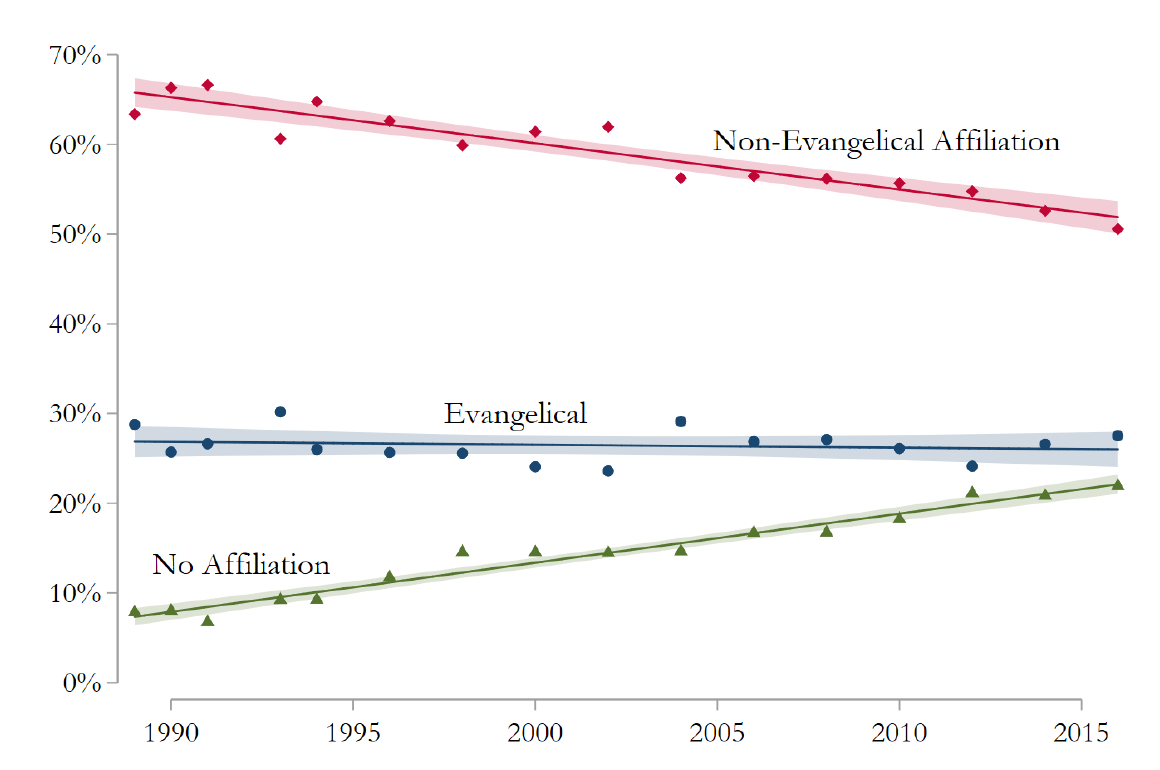
Figure 5: Type of affiliation over time, General Social Survey. Source: General Social Survey, 1989 to 2016. Note: The religious groups were categorized using the Steensland et al. (2000) religious classification schema. The “non-evangelical affiliation” category includes Catholics, mainline Protestants, “Black Protestants,” Jews, and “other